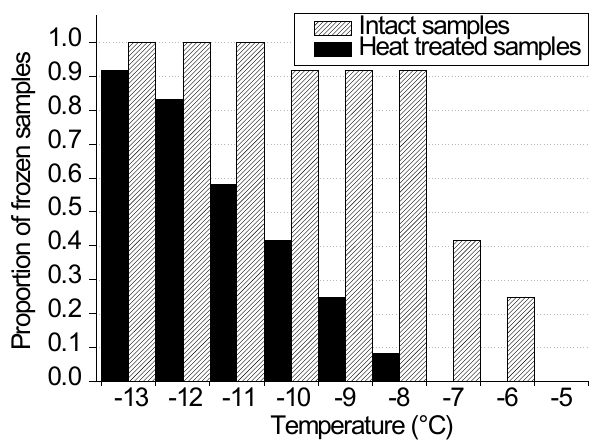
Figure 2. Cumulative proportion of cloud samples for which at least one freezing event was observed during IN assays, in the absence of treatment (shaded bars) or after heating at 95 ◦ C for 10min (black